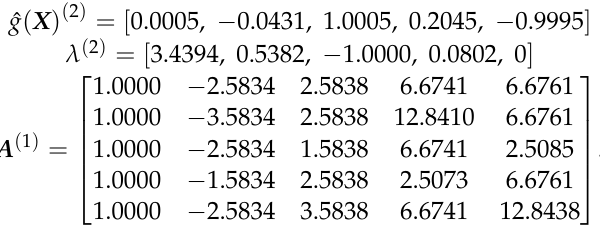
Figure 6. The steps of fitting the response surface to the limit state surface and searching for the